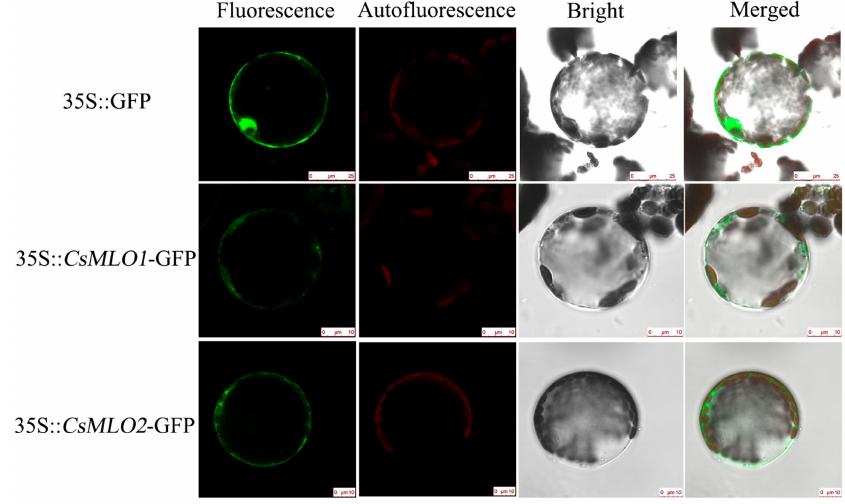
Figure 1. Subcellular localization of CsMLO1 and CsMLO2. Green fluorescence protein (GFP) was detected in the N. benthamiana protoplasts of the 35S::GFP, 35S:: CsMLO1 -GFP and 35S:: CsMLO2 -GFP constructs. CsMLO1::GFP and CsMLO2::GFP localized in the plasma membrane, GFP protein alone localized throughout the whole cells. Fluorescence, chloroplast autofluorescence, bright field and merged images were obtained using a Leica confocal microscope. Scale bars = 10 µ